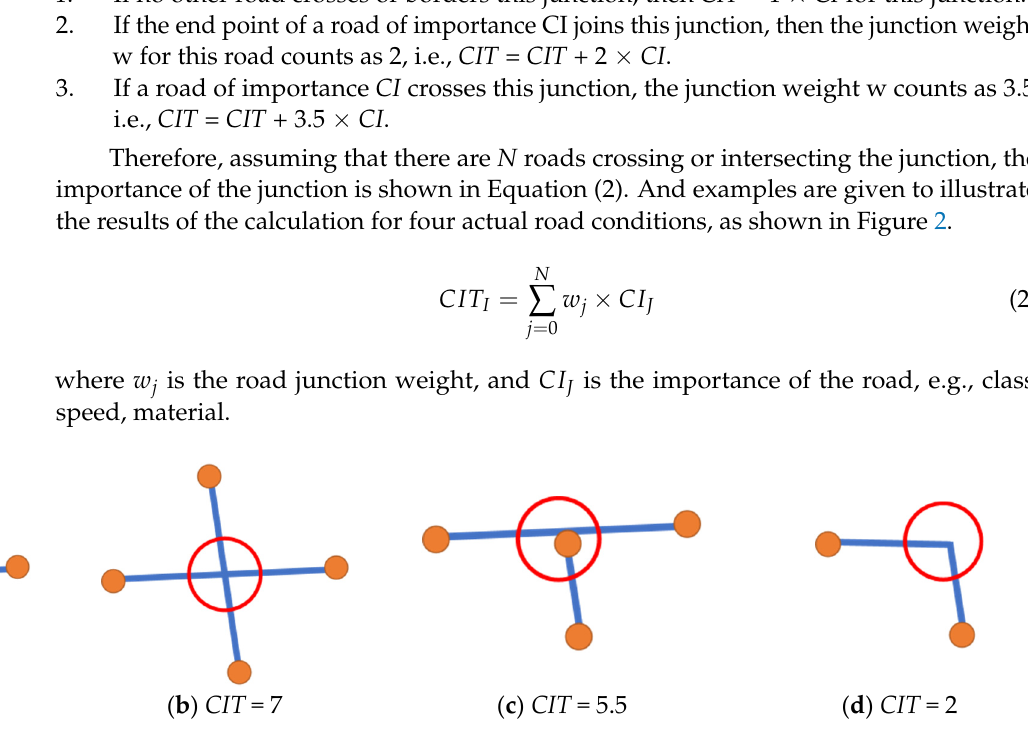
Figure 2. Road junction and corner importance target: Assuming that the importance of each road CI is 1, the CIT quantitative calculations are as follows. ( a ) Four roads intersect at a point, and each road is spatially connected to the junction, so the junction CIT = 2 + 2 + 2 + 2 = 8. ( b ) Two roads intersect at a single point, and each road crosses the junction in spatial relationship; therefore, the junction CIT = 3.5 + 3.5 = 7. ( c ) Two roads intersect at a point, one road crosses the junction, and the other road joins the junction, so the junction CIT = 3.5 + 2 = 5.5. ( d ) A corner of the road itself, so that the corner CIT = 2.